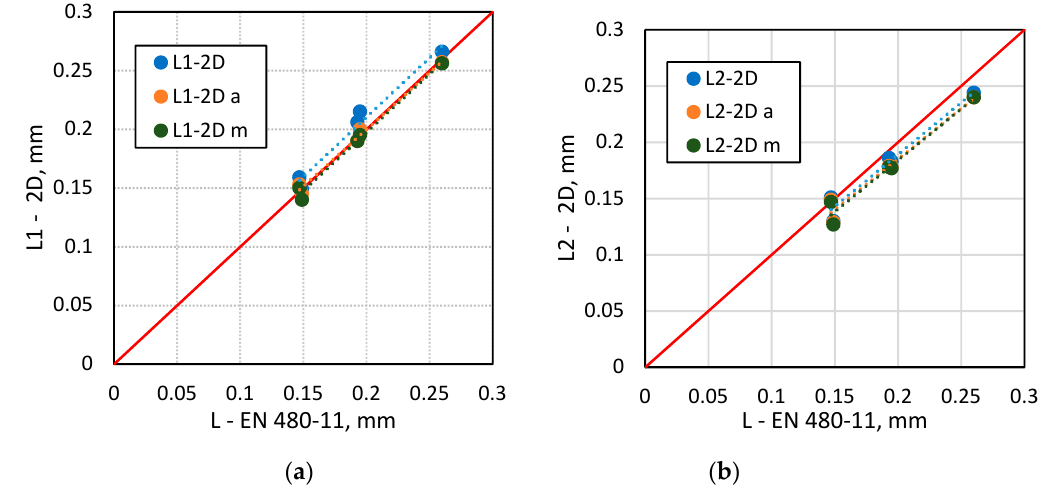
Figure 6. A comparison of EN 480-11 data versus 2D analysis results for α : a ) equivalent diameter based 2D analysis; b ) perimeter based 2D analysis.